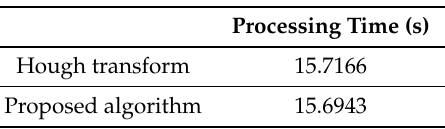
Figure 6. Comparison result of the line-detection algorithms: ( a ) Hough transform algorithm with post-processing, and ( b ) the proposed algorithm. Table 2. Results of the processing time using the proposed algorithm and the Hough transform algorithm when detecting walls.